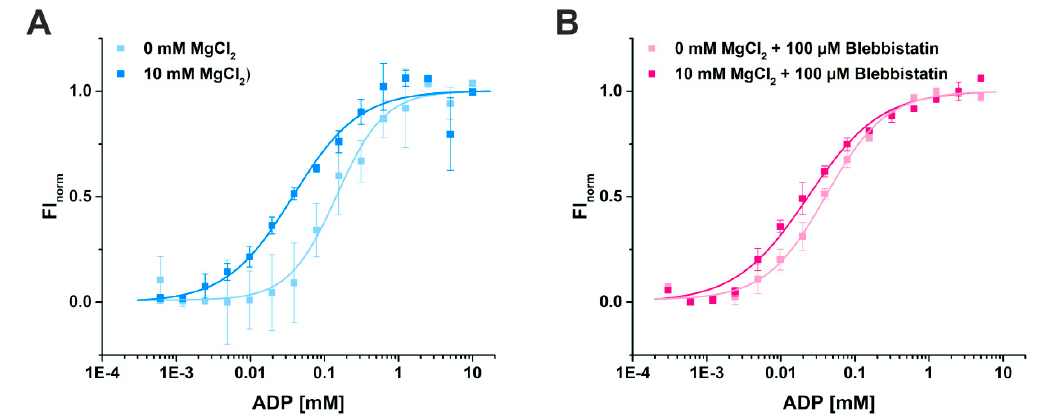
Figure 5. Binding assays of ADP to myosin-II using microscale thermophoresis. ( A ) The affinity of ADP for myosin-II in the absence of magnesium is reduced from K D = 37.5 ± 7.3 µM (10 mM Mg 2+ ) to 145.8 ± 19.3 µM (0 mM Mg 2+ ). ( B ) Addition of 100 µM blebbistatin increased the binding affinity of ADP for myosin-II, both in the presence (K D = 21.2 ± 3.4 µM) and absence of magnesium (K D = 40.6 ± 3.2 µM).